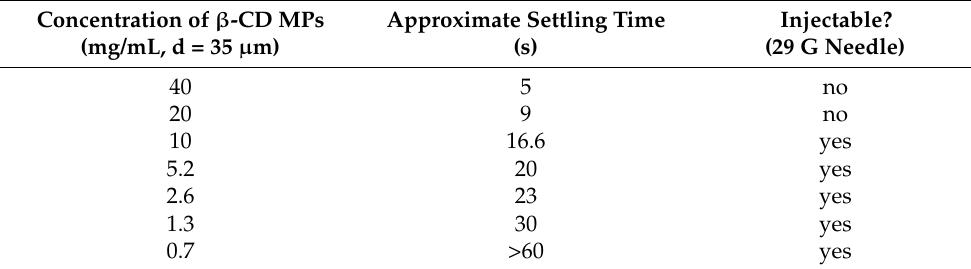
Table 3. Serial dilution of β-CD MPs in 1x PBS. Approximate settling times were measured subjec- tively when depositions of microparticles were first observed to crash out from solution. ‘Injectabil- ity’ was rated as a binary ‘yes’ or ‘no’ qualitative observation.